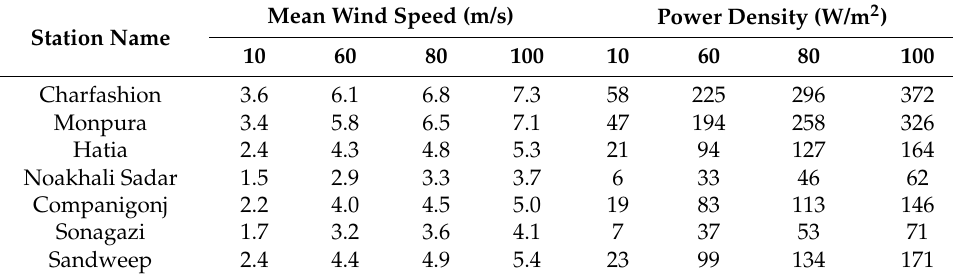
Table 5. Mean wind speed and power density estimation by